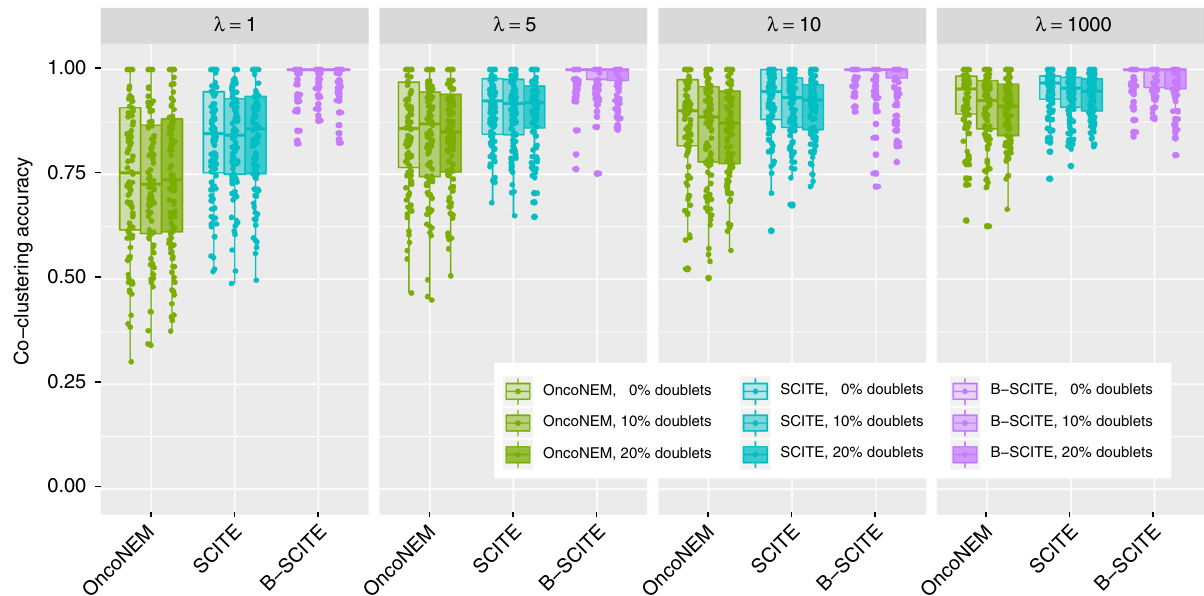
Fig. 4 Comparison of phylogenetic inference for OncoNEM, SCITE and B-SCITE for 100 simulated clonal trees with 10 nodes (clones) and 50 mutations. For the single-cell data, we drew 25 genotypes from each clonal tree for various values of parameter λ , which controls bias in sampling single cells from clones (large values of λ indicate a small bias, the where probability of drawing a single cell from a given clone is usually close to its prevalence in the entire tumour cell population). We also added the following noise to the single-cell genotypes: false-positive rate 10 − 5 , false-negative rate 0.2, missing (NA) rate 0.05 and doublet rates 0, 0.1 and 0.2. Bulk data coverage was set to 10,000, and variant read counts drawn from a binomial distribution. We obtained data sets from trees for each parameter combination. A more detailed description of the simulation data and the de fi nition of the co-clustering accuracy measure are given in Supplementary Methods. Source data are provided as a Source Data fi